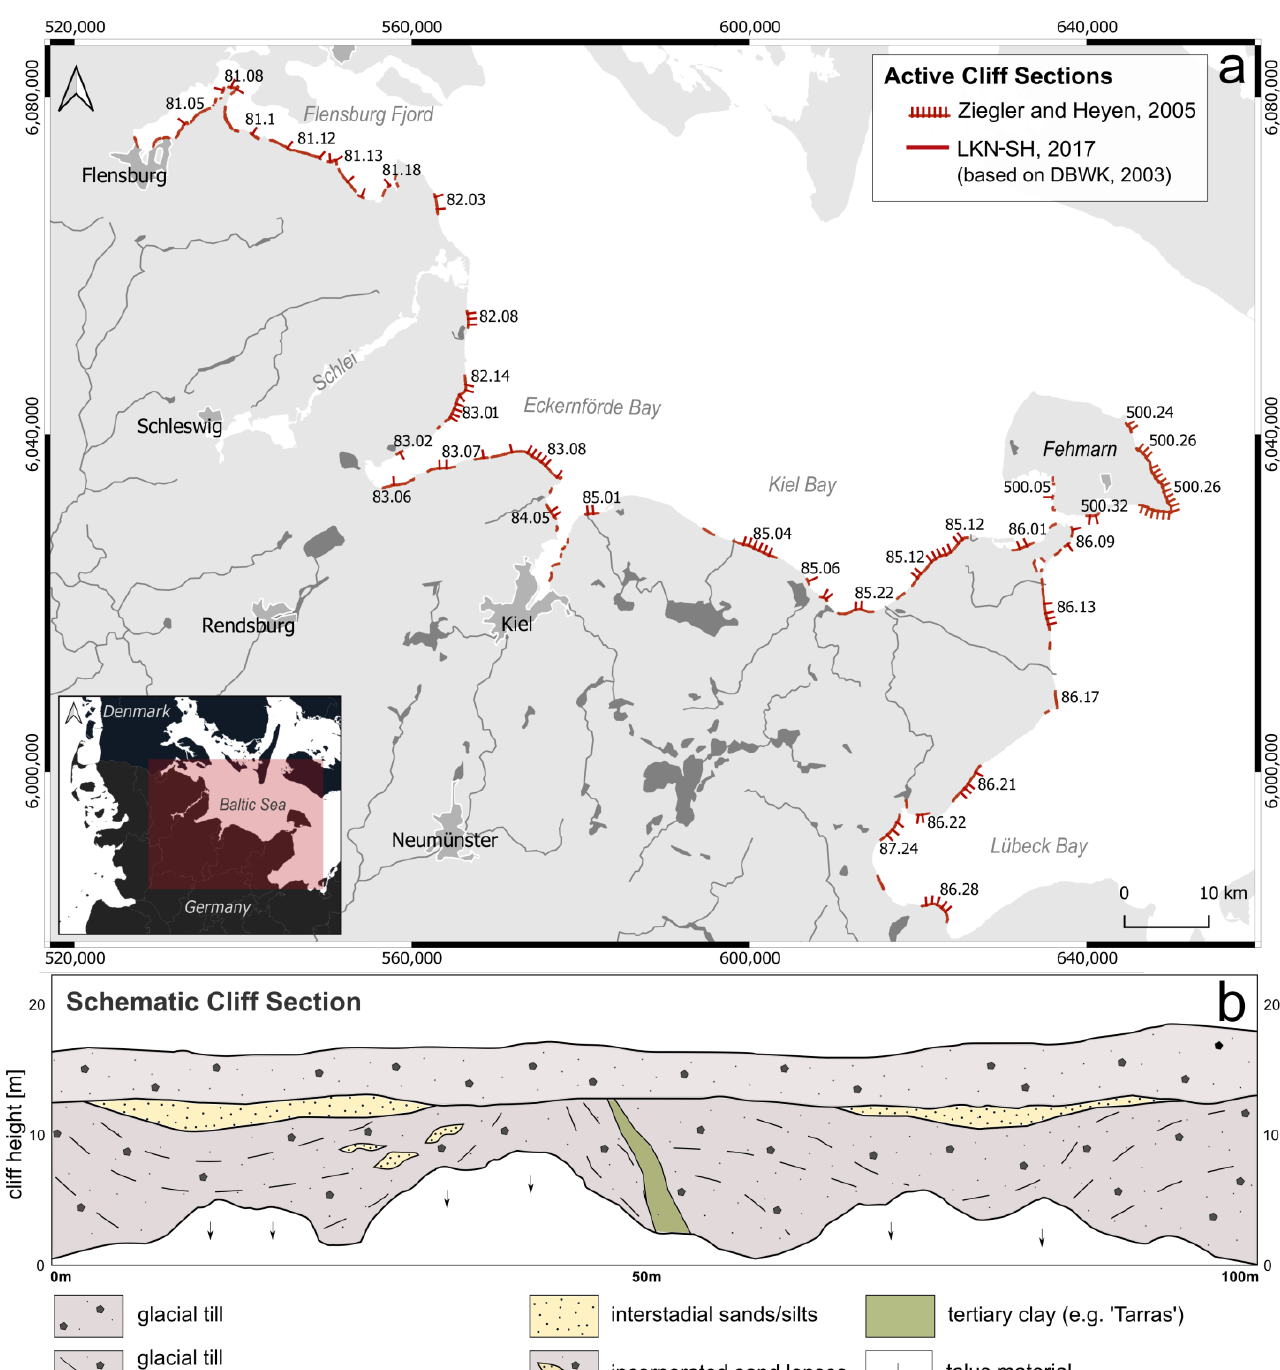
Figure 1. ( a ) Baltic Sea coastline of S-H, Germany, with active cliff sections defined by Ziegler and Heyen [36] and LKN- SH [35] based on the digital map of federal waterways (DBWK 2003) [37]. Labels refer to the numbers of the coastal subsections where the cliffs are located (mainland: 81.01–86.32; Fehmarn Island: 500.01–500.32) [35]. ( b ) Schematic overview of a typical Pleistocene cliff deposit in the study area.